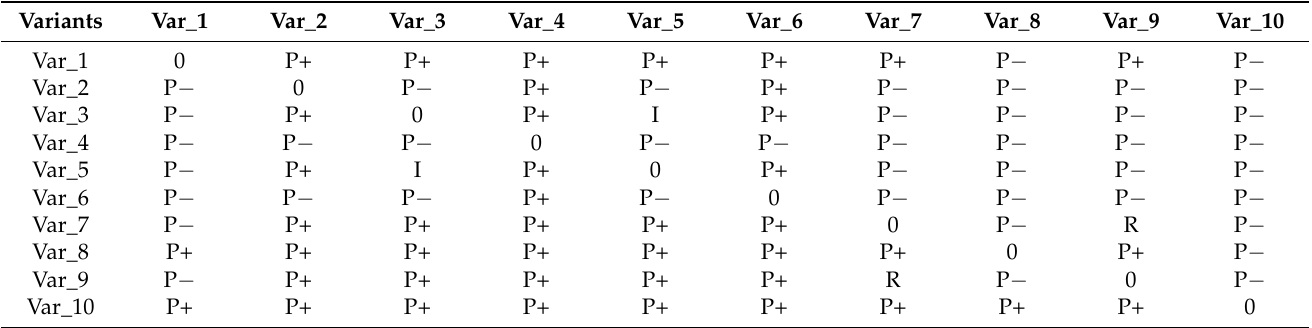
Table 7. Dominance matrix values from the point of view of the surveyed